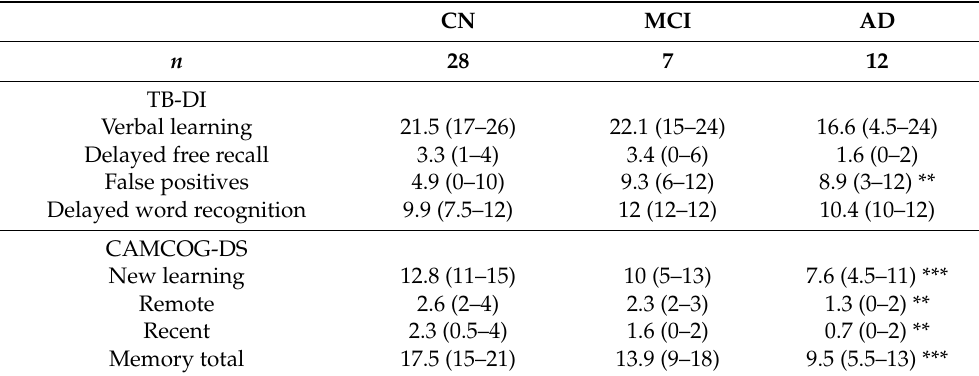
Table 3. Cognitive scores by group for moderate intellectual disability sample.